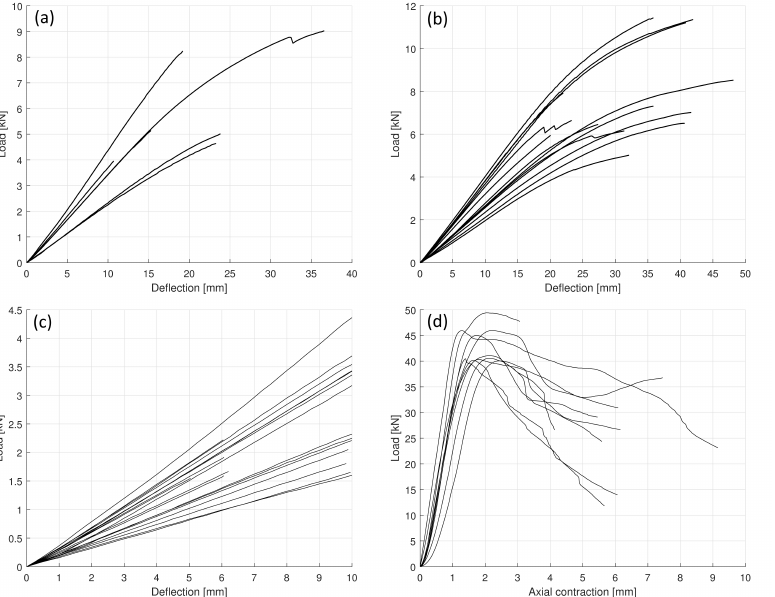
Figure 5. Load–displacement curves from all tests. ( a ) Load–deflection curves of non-reinforced specimens (group 0) from bending tests until failure. ( b ) Load–deflection curves of beams reinforced with carbon-fibre fabrics (group F) from bending tests until failure. ( c ) Load–deflection curves for all specimens without reinforcement from bending tests in the elastic range. ( d ) Load–displacement curves from axial compression